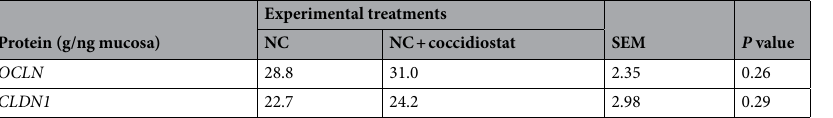
Table 2. Effect of coccidiostat supplementation on ileal OCLN and CLDN1 protein expression (SEM: standard error of mean).